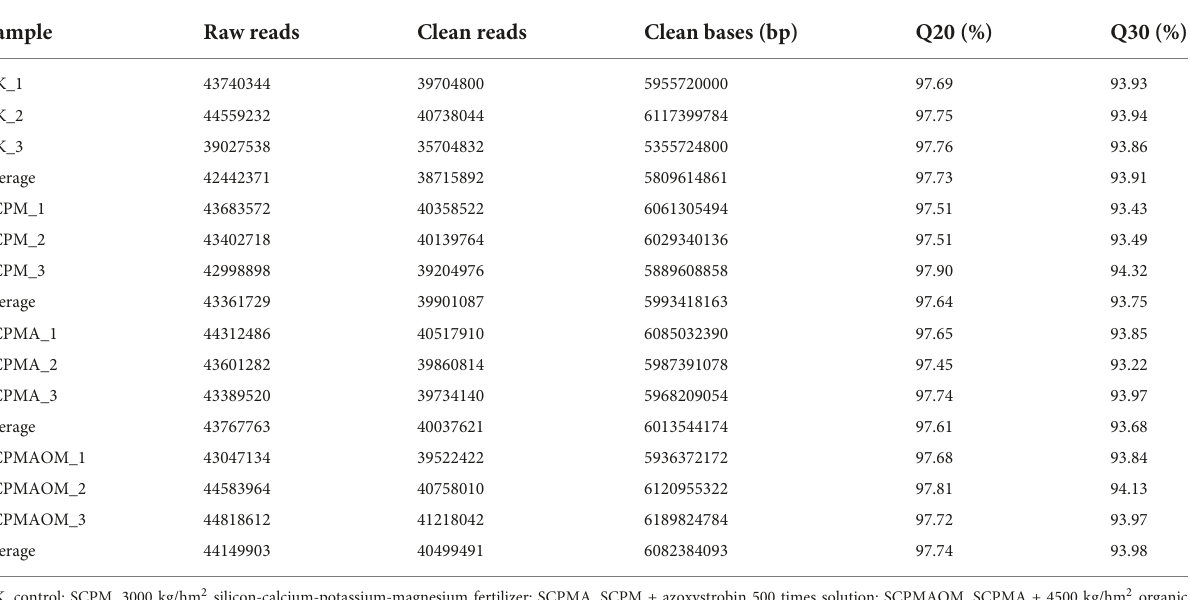
TABLE 4 Overview of the sequencing data.